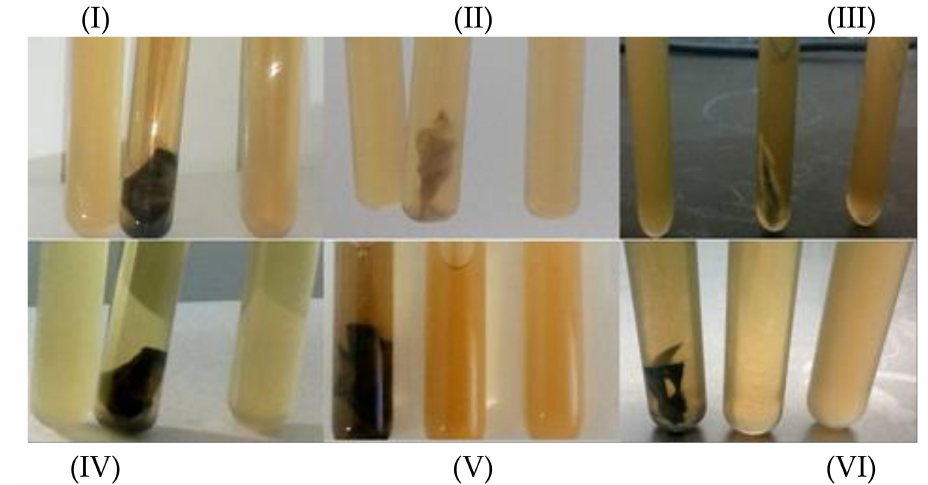
Figure 4. Confirmation test of the e ffi ciency of the adsorption process on E.coli growth (at initial concentration 500 mg L − 1 , adsorbent dose 2 mg mL − 1 , and pH 5.5) represented by three tubes, containing E.coli culture, E.coli culture with filtrated adsorbent loaded with antibiotics, and E.coli culture with filtrate solution, respectively. ( I ) Garamycin / MSG, ( II ) Garamycin / SG, ( III ) Garamycin / HRGO, ( IV ) Ampicillin / SG, ( V ) Ampicillin / MSG, and ( VI ) Ampicillin /